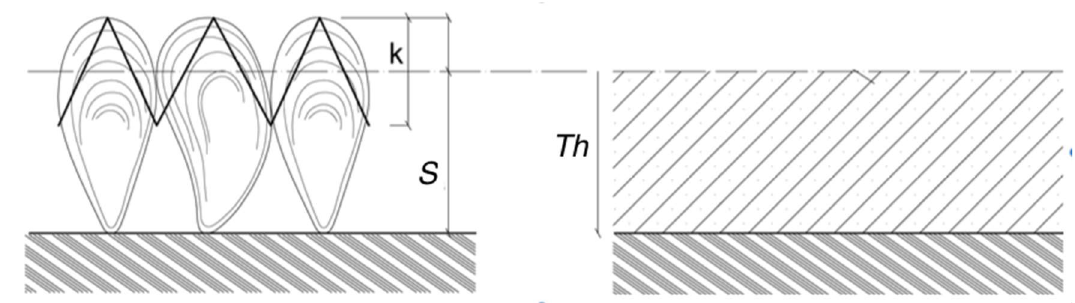
Figure 9. From biological reality to mechanical abstraction.